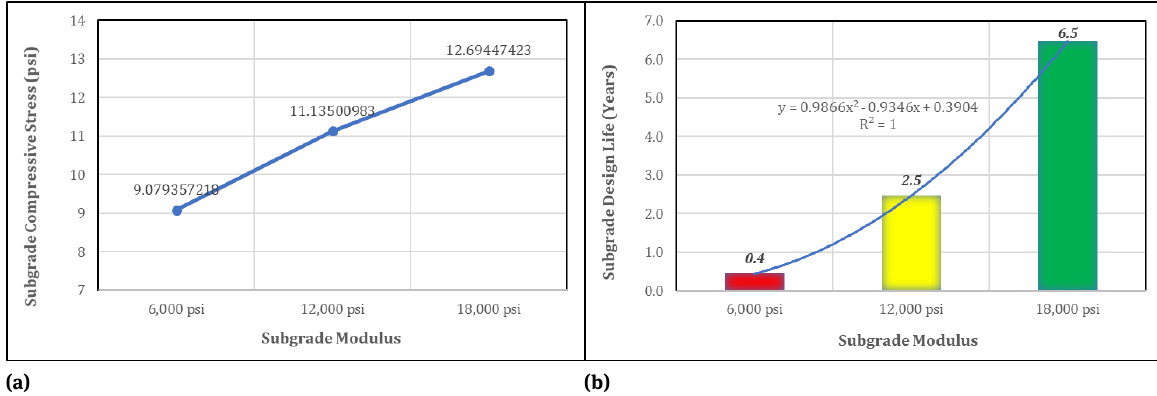
Figure 24: Influence of subgrade modulus on subgrade compressive stress (a) and on subgrade service life (b) in granular rail track.